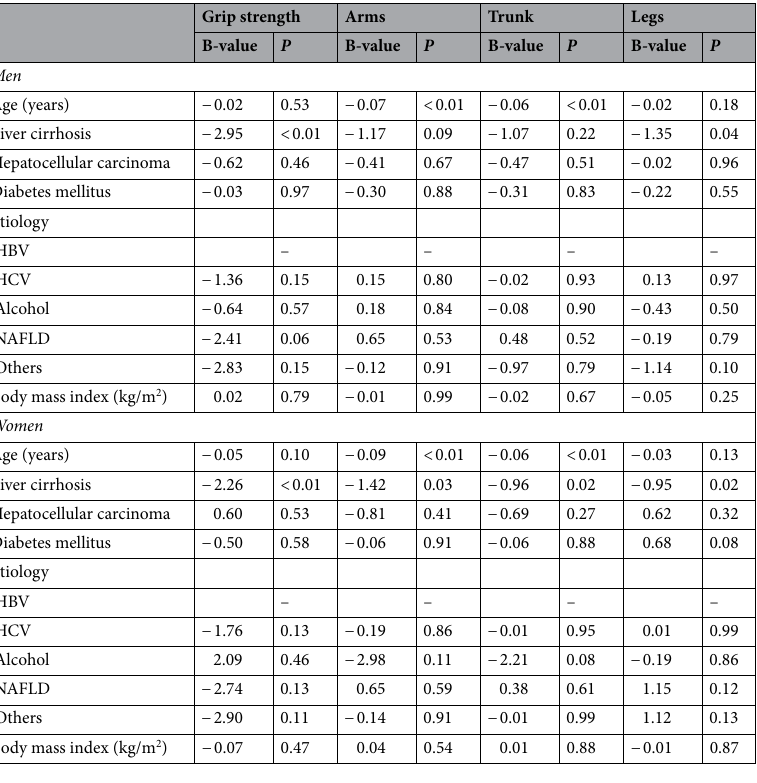
Table 3. Factors associated with the rate of change in sarcopenia-relevant factors. HBV, hepatitis B virus; HCV, hepatitis C virus; NAFLD, nonalcoholic fatty liver